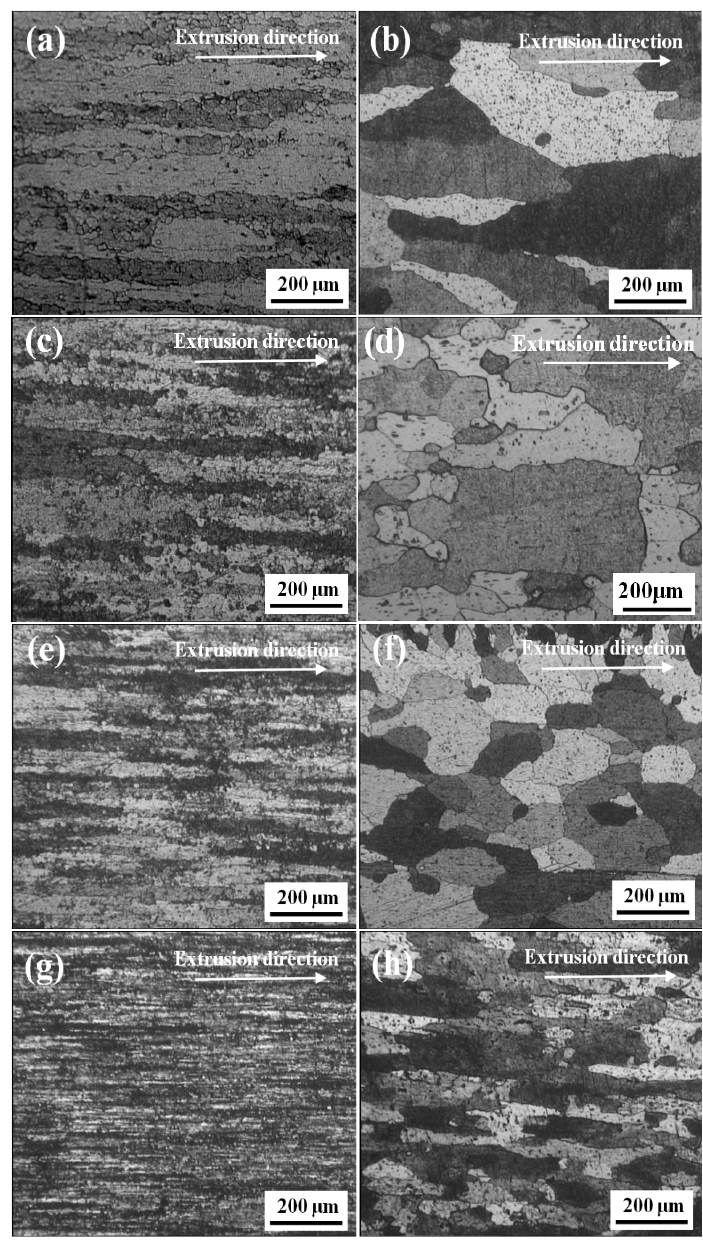
Figure 2. Optical micrographs of alloys at different states: ( a ) as-extruded Alloy 1, ( b ) as-quenched Alloy 1, ( c ) as-extruded alloy 2, ( d ) as-quenched Alloy 2, ( e ) as-extruded Alloy 3, ( f ) as-quenched Alloy 3, ( g ) as-extruded alloy 4, ( h ) as-quenched Alloy 4.